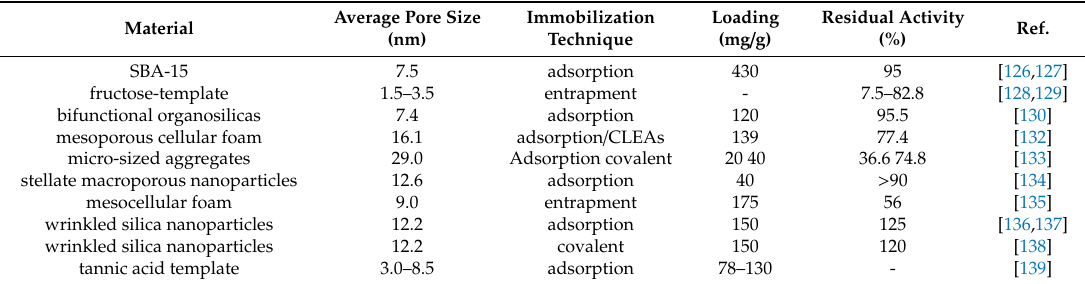
Table 1. Summary of β -glucosidase (BG) immobilization on various mesoporous silica materials. CLEA, cross-linked enzyme aggregate; SBA-15, Santa Barbara Amorphous no 15. Average Pore Size Immobilization Loading Material (nm) Technique (mg /